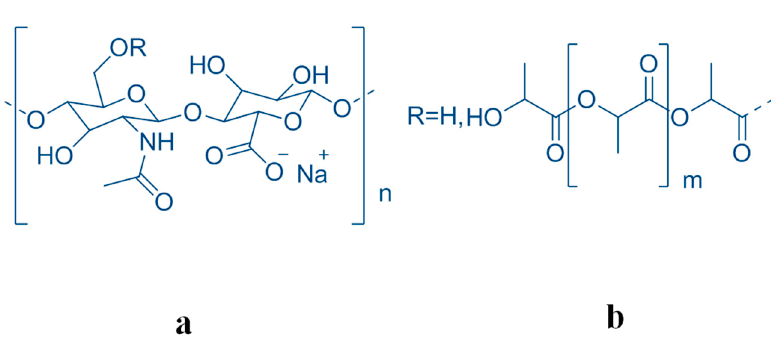
Figure 1. The molecular moieties ( a ) hyaluronic acid (HA) and ( b ) polylactic acid (PLA) forming the copolymer HA-PLA (b / a + b = 13% w / w ).